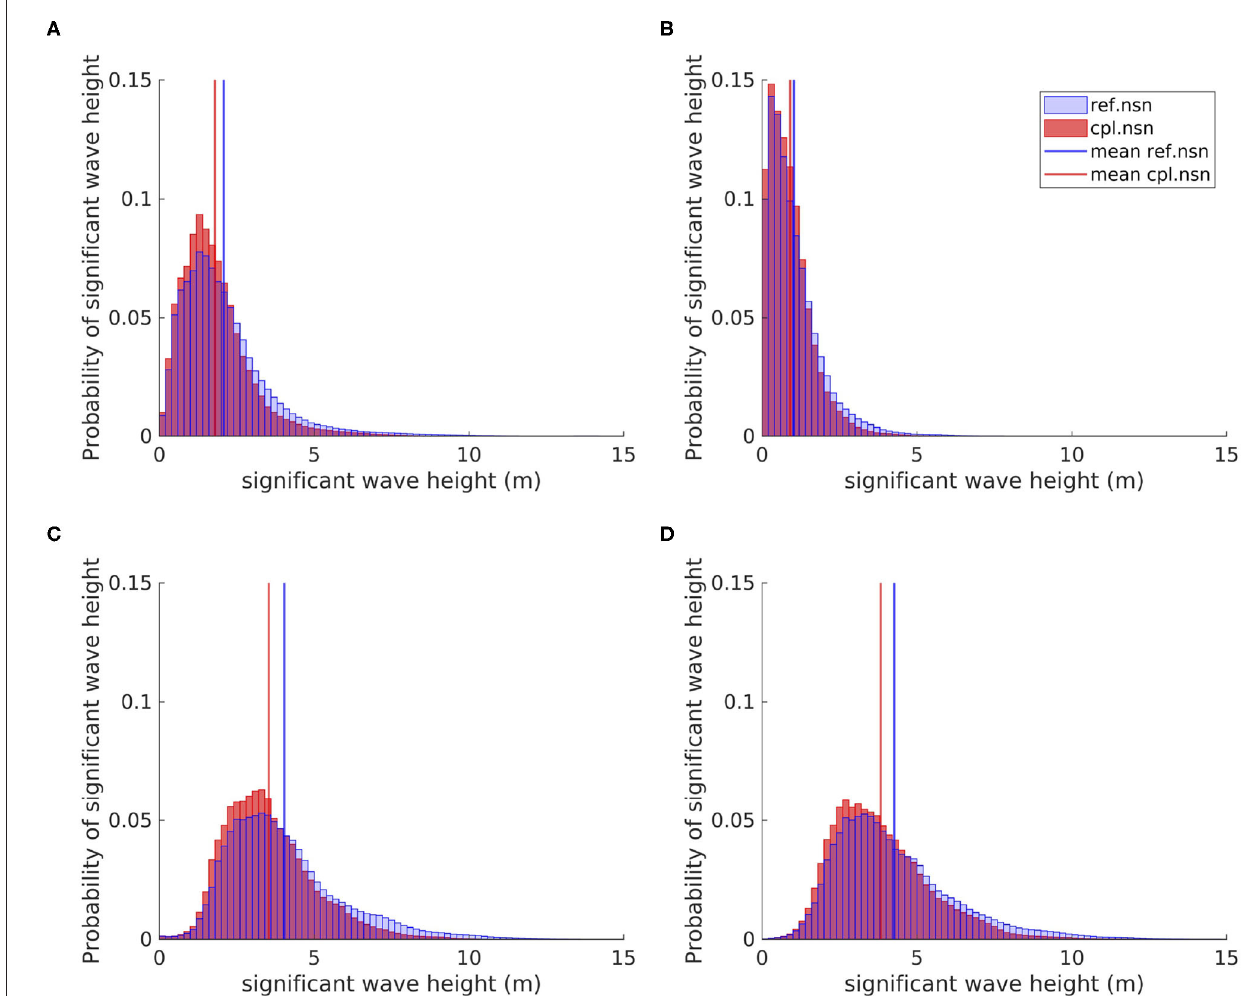
FIGURE 4 | Histogram of the significant wave heights of the reference (ref.nsn) and coupled (cpl.nsn) ensembles within the North Sea (A) , the Baltic Sea (B) , the southern Norwegian Sea (C) , and the North Atlantic Ocean west of the British Isles (D)